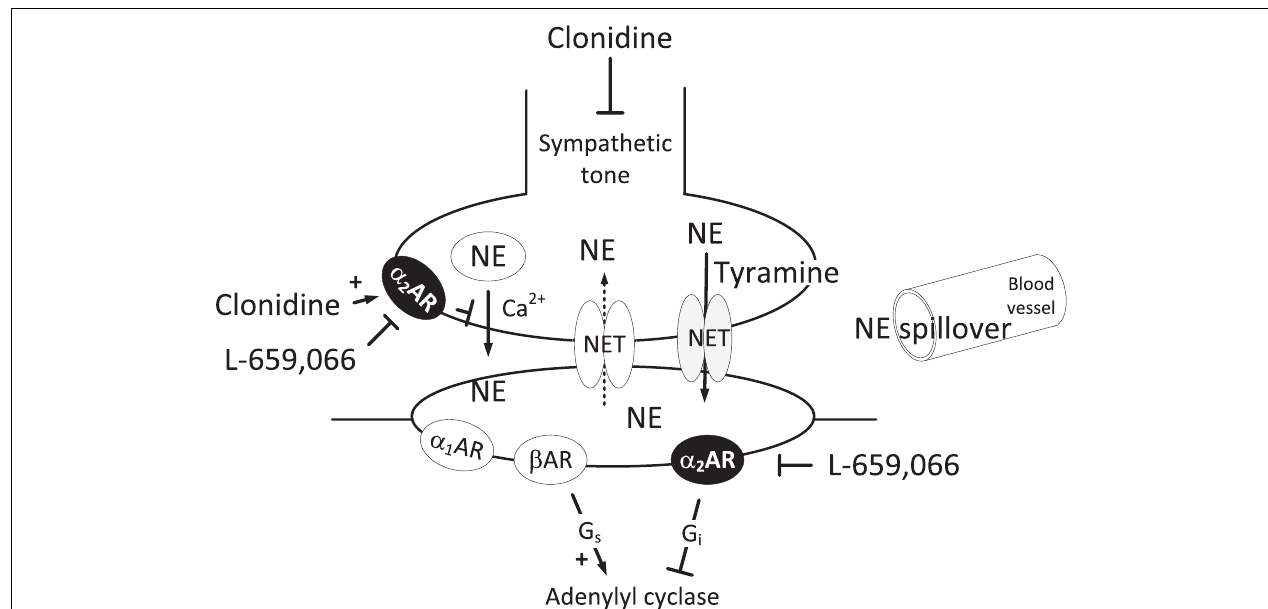
the α 2 AR or other presynaptic receptors. Clonidine will lower the sympathetic tone through a central action, as well as stimulate presynaptic and postsynaptic α 2 AR. L-659,066, which does not cross the blood-brain barrier, will inhibit the peripheral pre- and postsynaptic α 2 AR. In theVSMC, L-659,066 will allow β AR-G s -signaling to dominate tension control when norepinephrine release is stimulated. Blunted arrows indicate